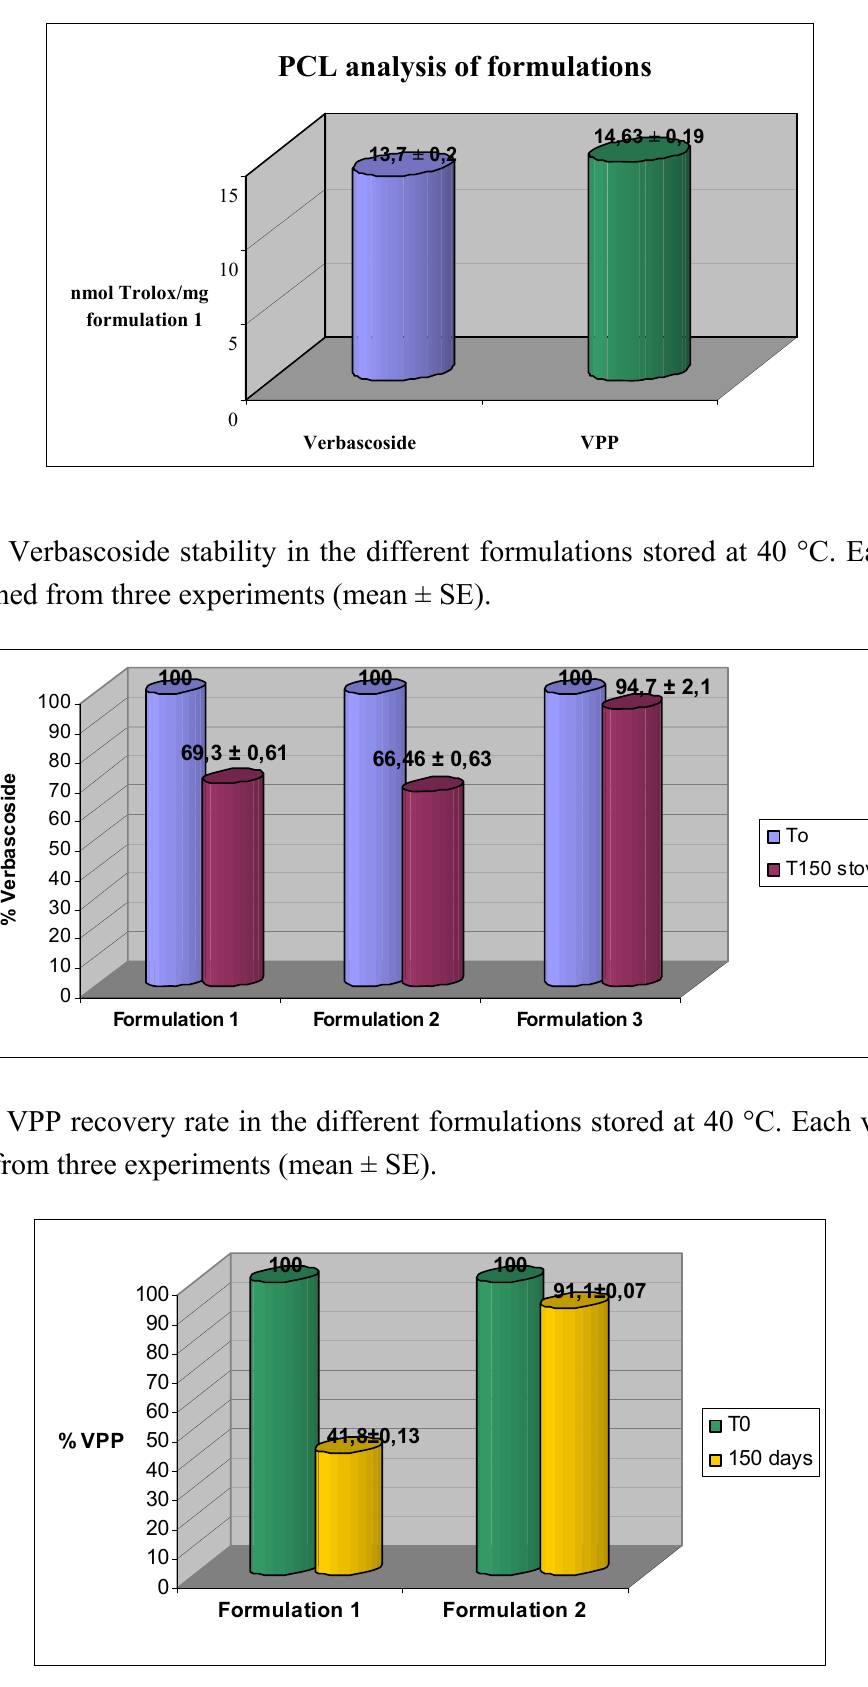
Figure 4. PCL analysis of formulations 1 with verbascoside and VPP. Each value was obtained from three experiments (mean ± SE).